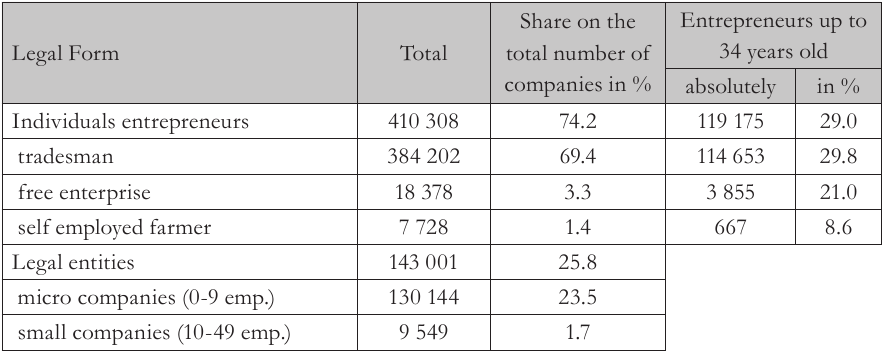
Tab. 1 - Numbers of Entrepreneurs by the Legal Form and Size. Source: Company register of Statistic Bureau, 2010, processed by